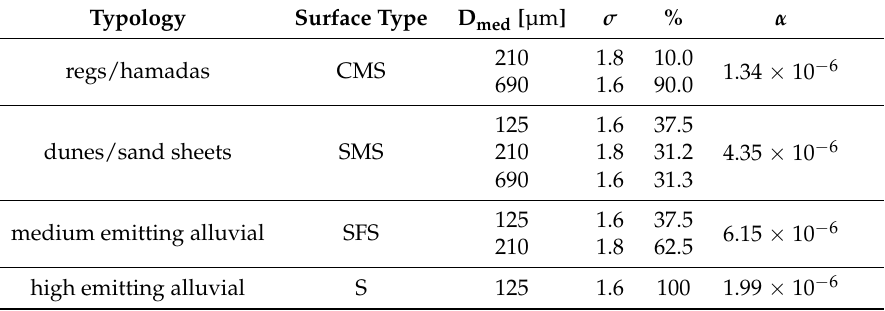
Table 2. Statistical parameters of the soil size distributions assumed for the present surface types according to Marticorena et al. [58] and Laurent et al. [59] that were used for the model implementation of the SSM. α represents the respective saltation efficiency of the surface types, defined by Equation